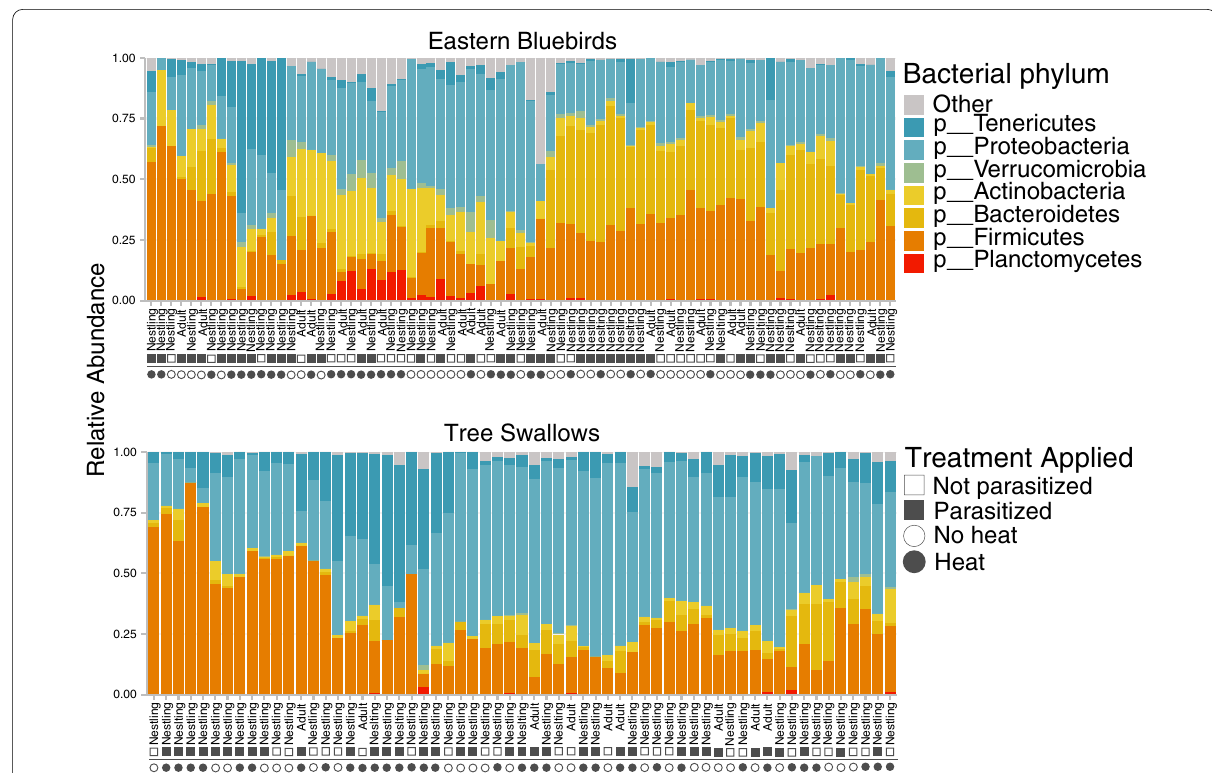
Fig. 2 Proportional abundance of bacterial phyla identified from eastern bluebird (top) and tree swallow (bottom) microbiota arranged by hierarchical clustering of Euclidean distances. Each bar represents a sample from an individual